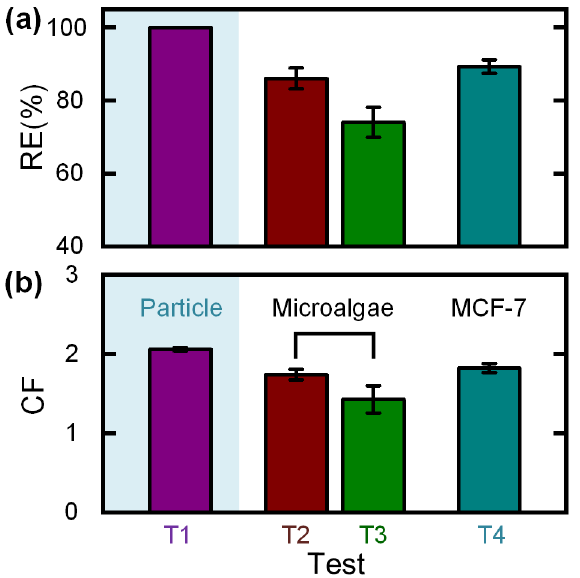
Figure 5. ( a ) Recovery efficiency (RE) and ( b ) concentration factor (CF) of 10 µ m standard-sized particles, microalgal cells, and MCF-7 tumor cells under different experimental tests (T1 − T4). Tests T1, T2, and T4 were performed with the integrated device using 10 µ m standard-sized particles, microalgal cells, and MCF-7 cells, respectively. Test T3 was a control experiment on the concentration of microalgal cells using a device without a flow stabilizer. All the experiments were repeated five times under the hand-operated mode. The error bar in this figure denoted the standard deviation.